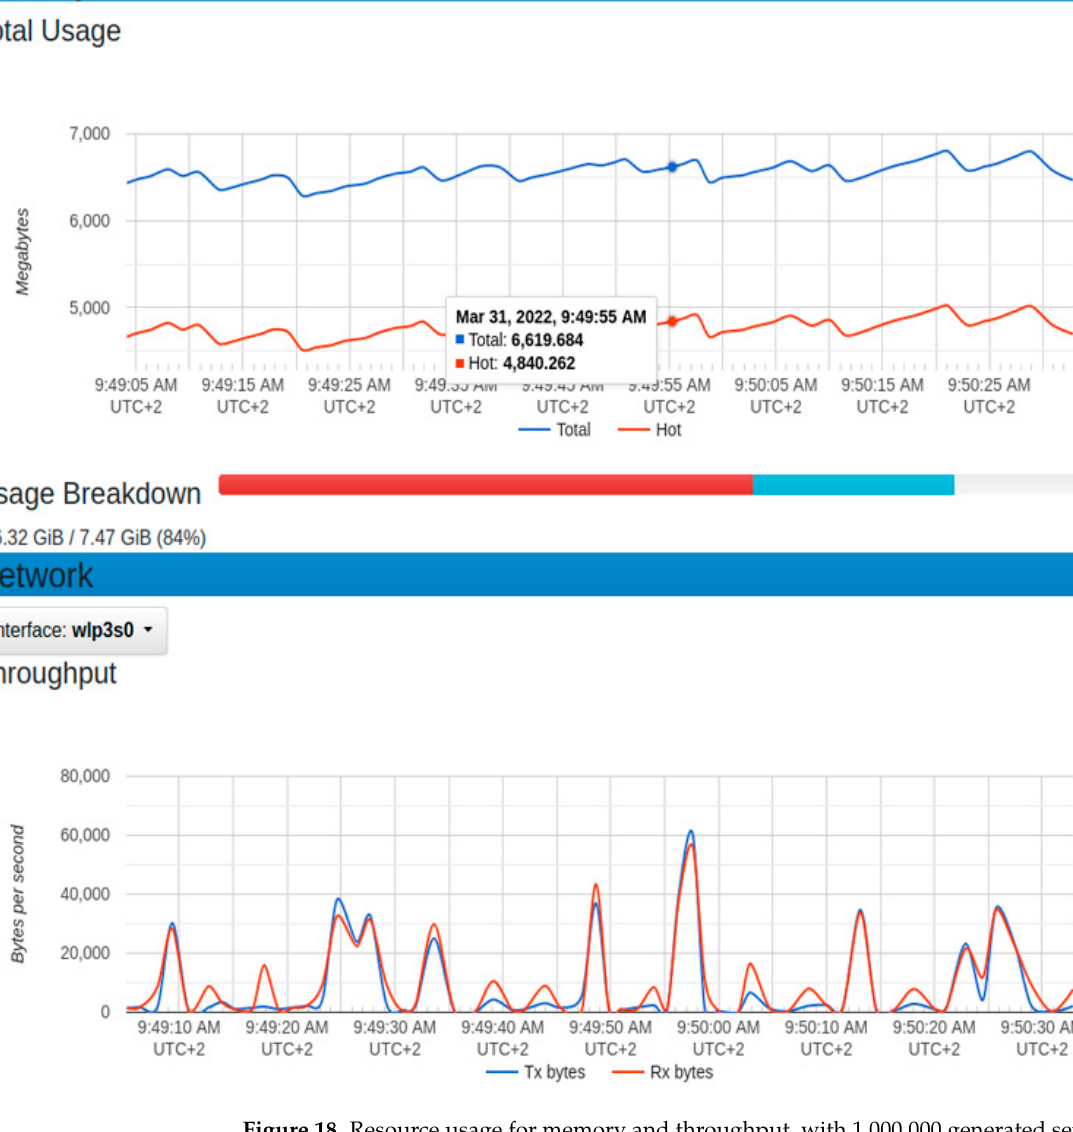
Figure 18. Resource usage for memory and throughput, with 1,000,000 generated sensor requests.